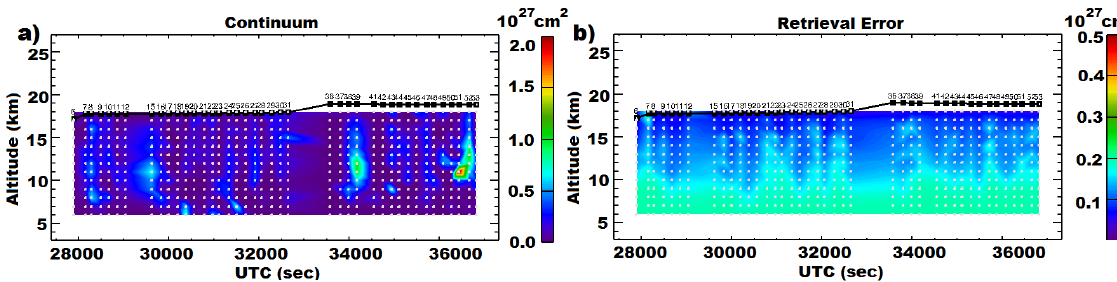
Fig. 17. (a) External continuum retrieved from all bands and (b) its retrieval (biased) error. Units 10 27 cm 2 .